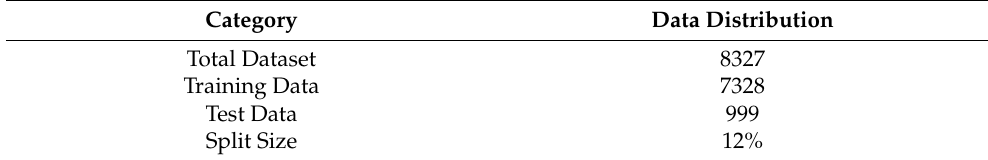
Table 1. Dataset